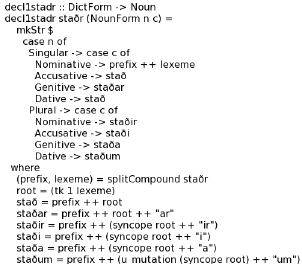
Figure 4. FM implementation of Old Icelandic masculine i -stem noun. Each declension entry is defined towards the end of the segment. Functions like ‘u_mutation’ or ‘syncope’ operate on the declension entry in question to execute the desired string